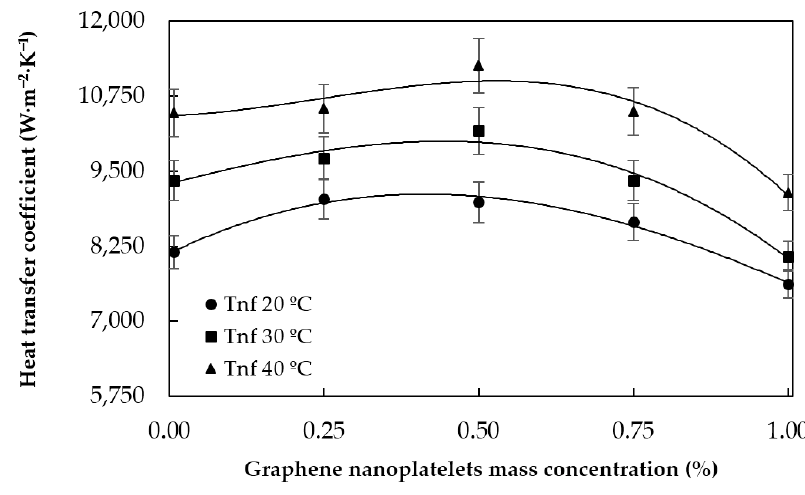
Figure 9. Heat transfer coefficient against graphene nanoplatelet concentration at different temperatures with a flow rate of 300 L·h − 1 . The LMTD at the heat exchanger is 20 °C.